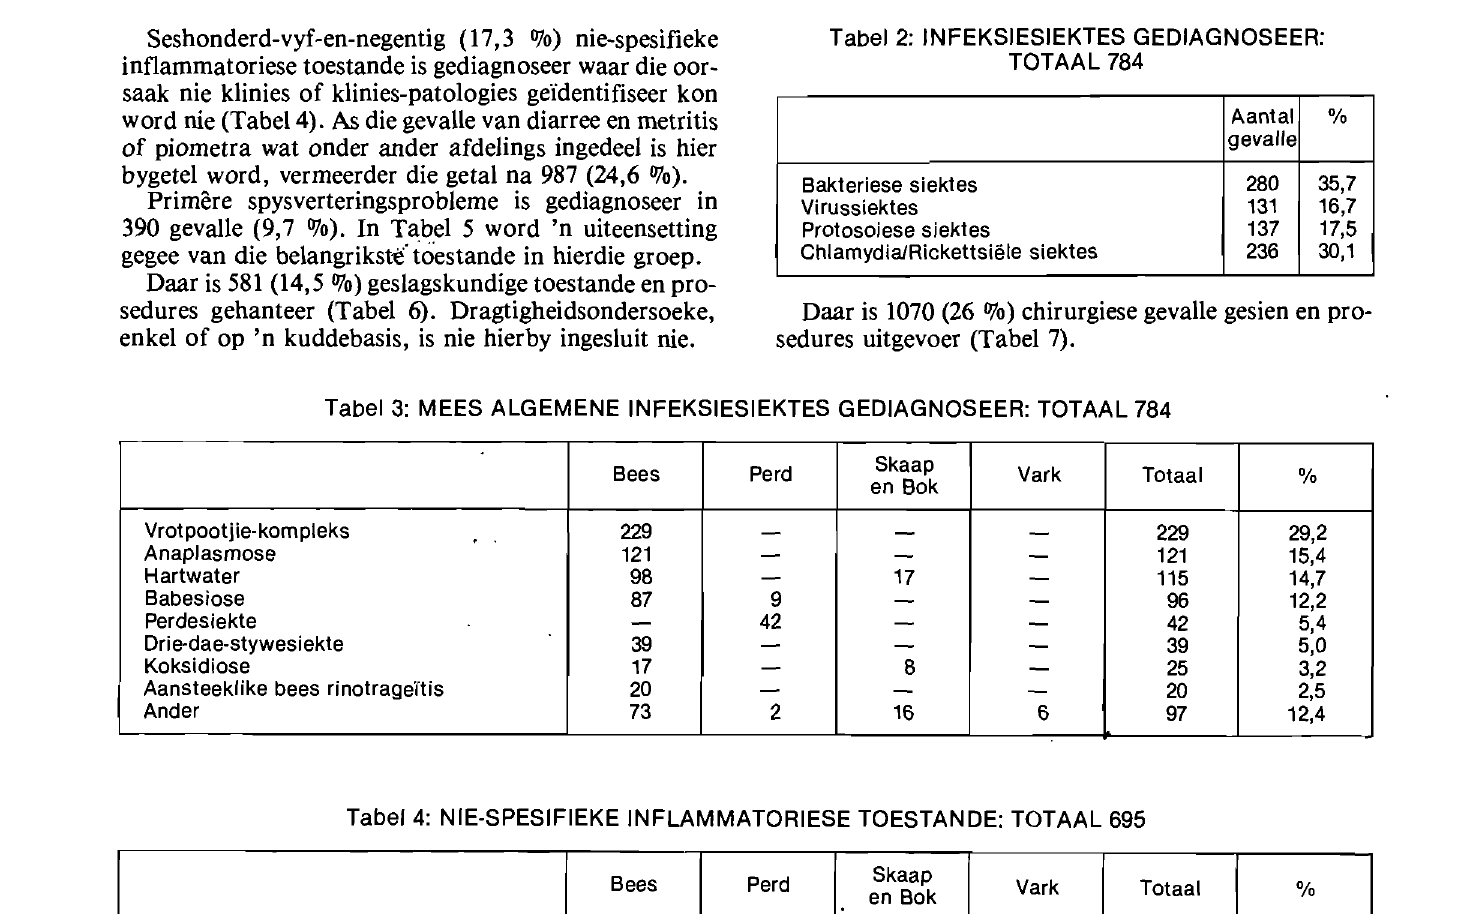
Tabel 5: PRIMERE SPYSVERTERINGSKANAALPROBLEME: TOTAAL